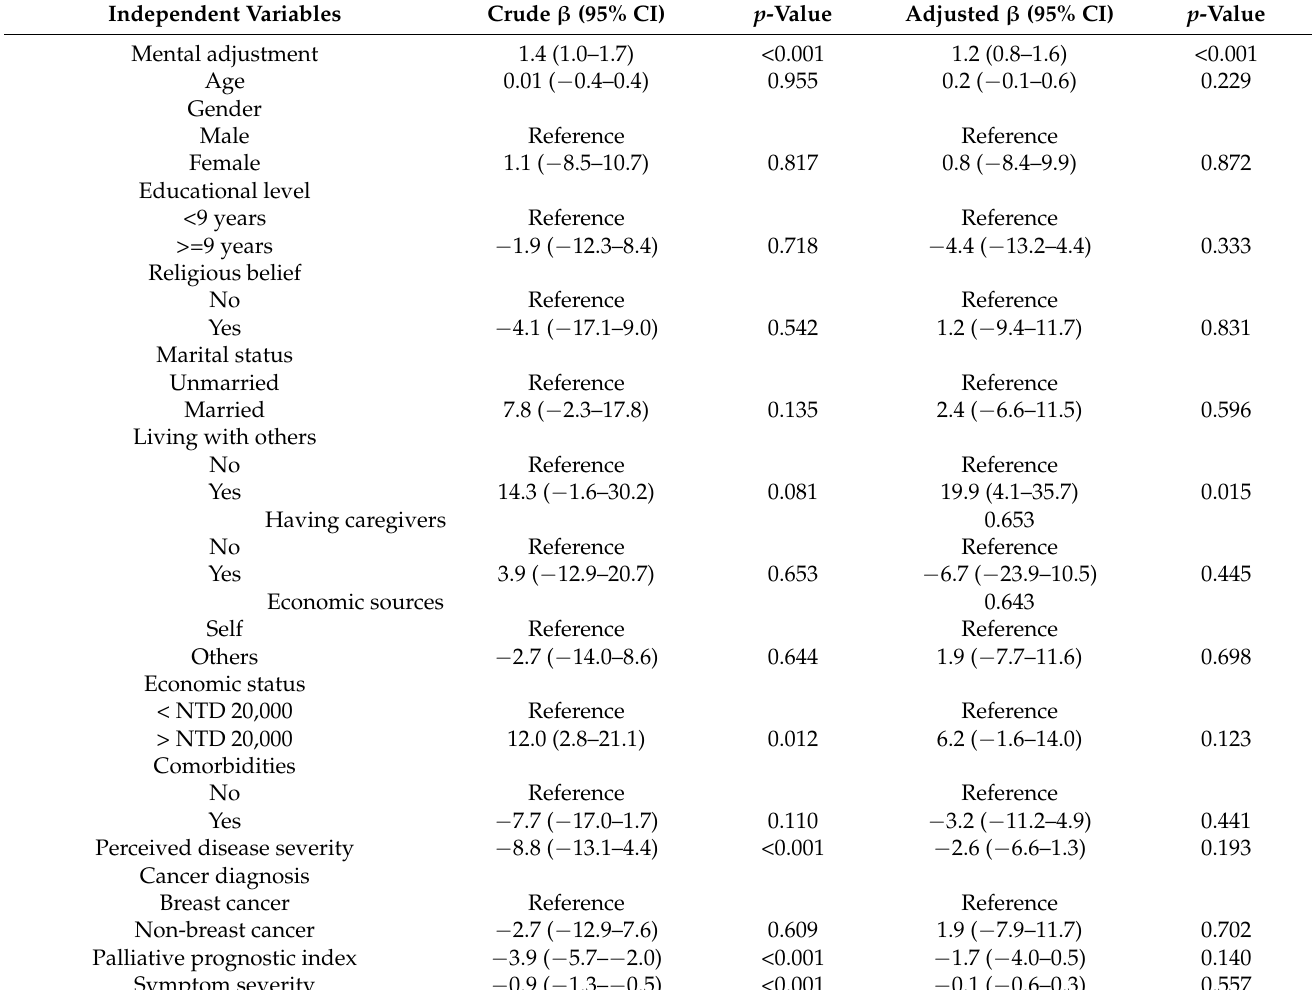
Table 3. Predictors of comprehensive quality of life outcome (CoQoLO) among terminally ill cancer patients (N = 117). Independent